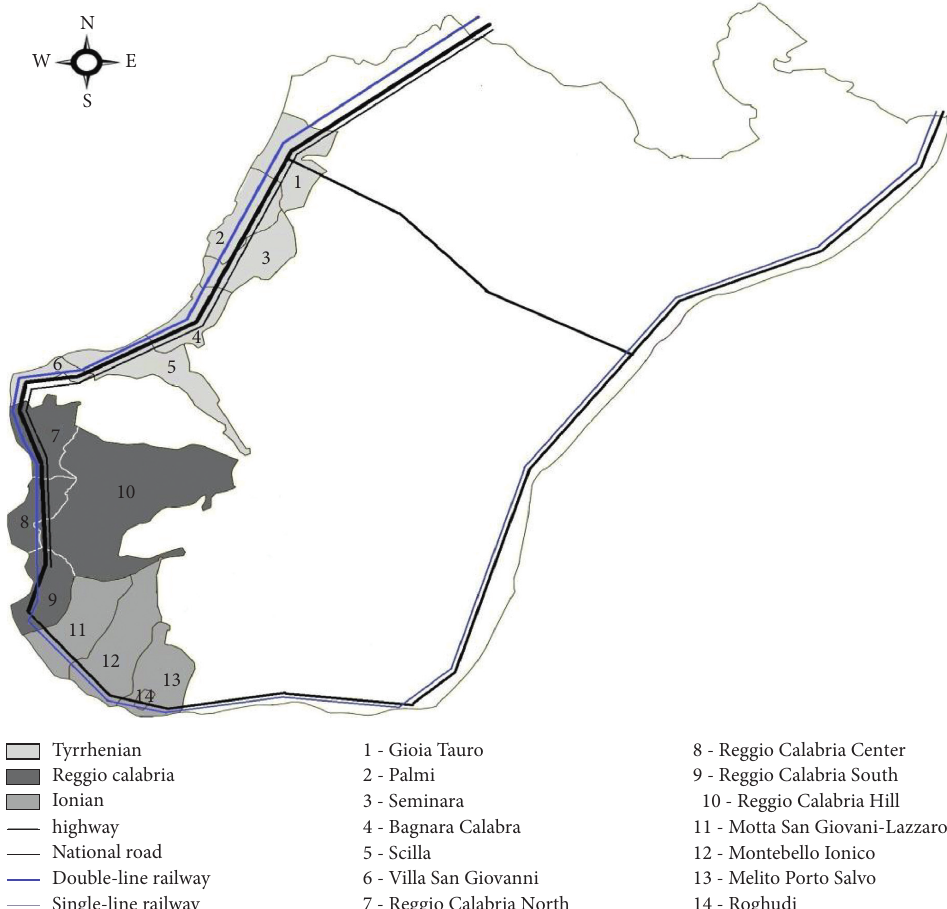
Figure 1: Study area, zoning, and itineraries of main transport